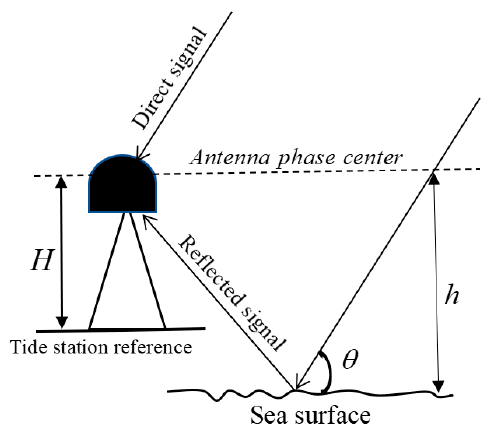
Figure 1. The tidal-level inversion model.